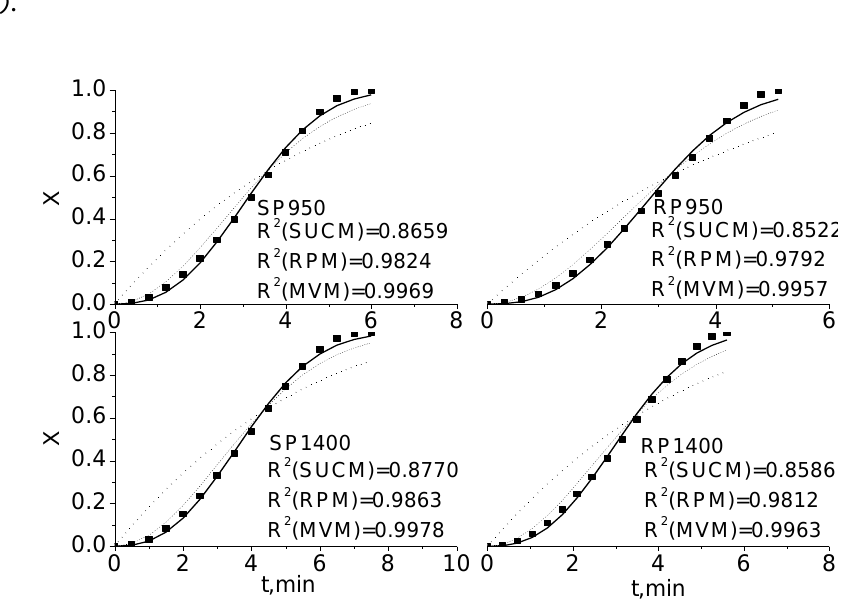
Figure 2. Carbon conversion versus gasification time for coal char gasification at the gasification temperature of 1,400 °C. Experimental data ( ■ ); SUCM (  ); RPM (---); MVM